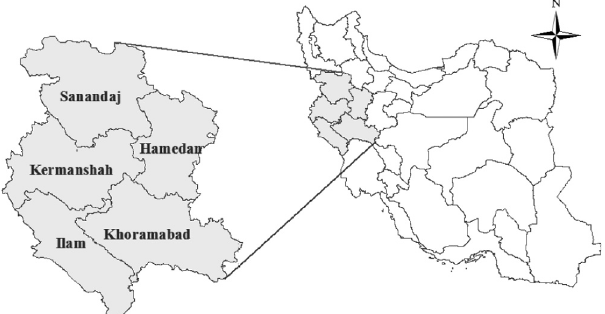
Figure 1. Location of the stations used in